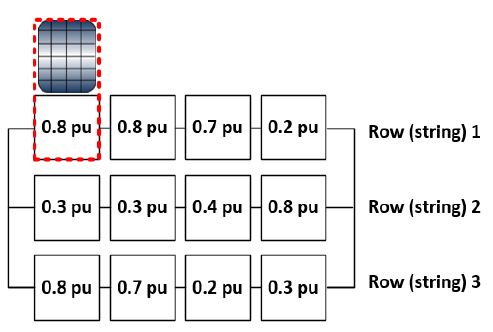
Figure 9. A 3 × 4 PV array SP configuration with non-uniform aging.